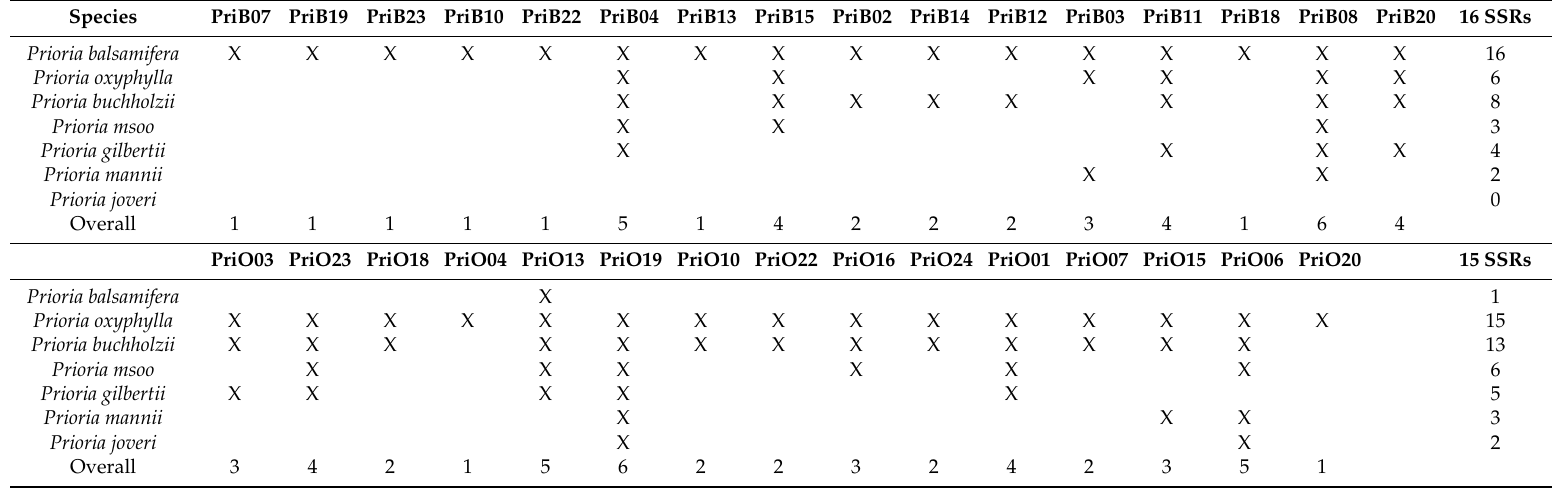
Table 3. Results of the cross-species amplification tests in the African Prioria species. x indicates successful